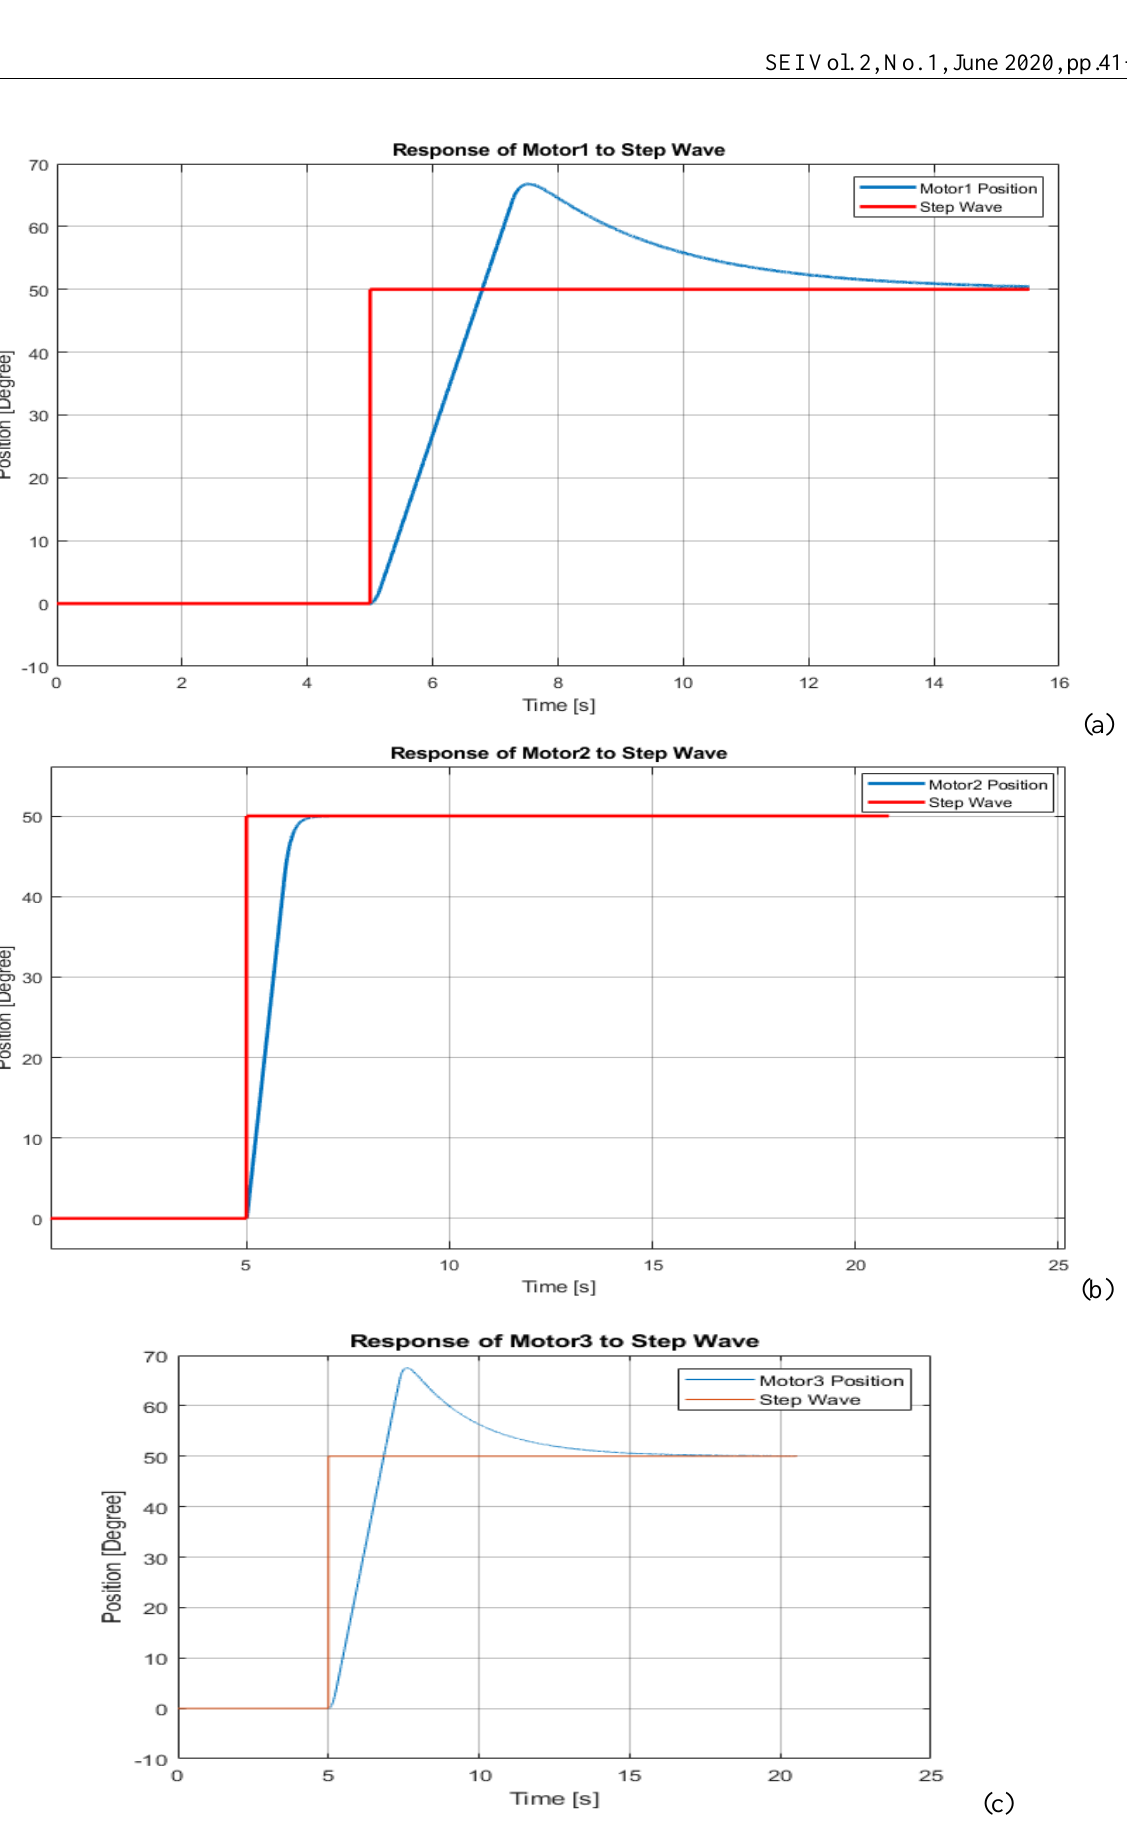
Figure 18. Step response of the system, a) Joint 1, b) Joint 2 c) Joint